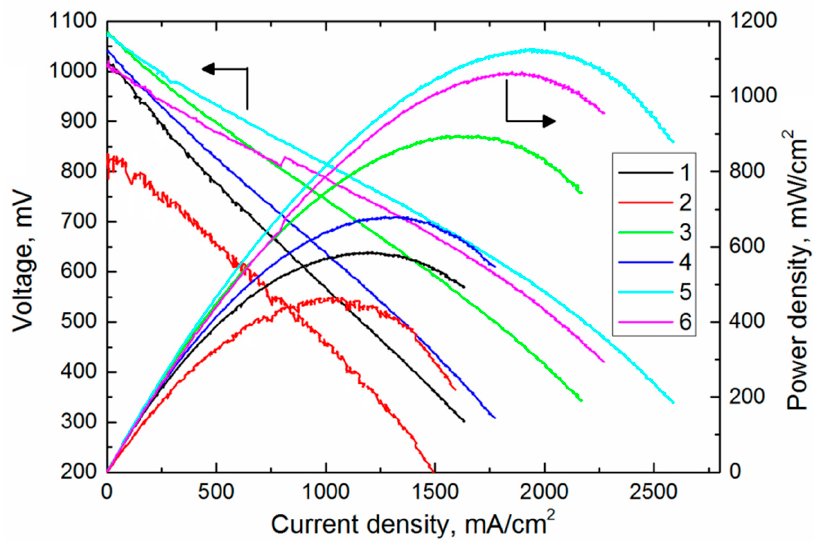
Figure 7. Volt-ampere characteristics of SOFCs fabricated from YSZ electrolyte films 1–6 at 800 ° С